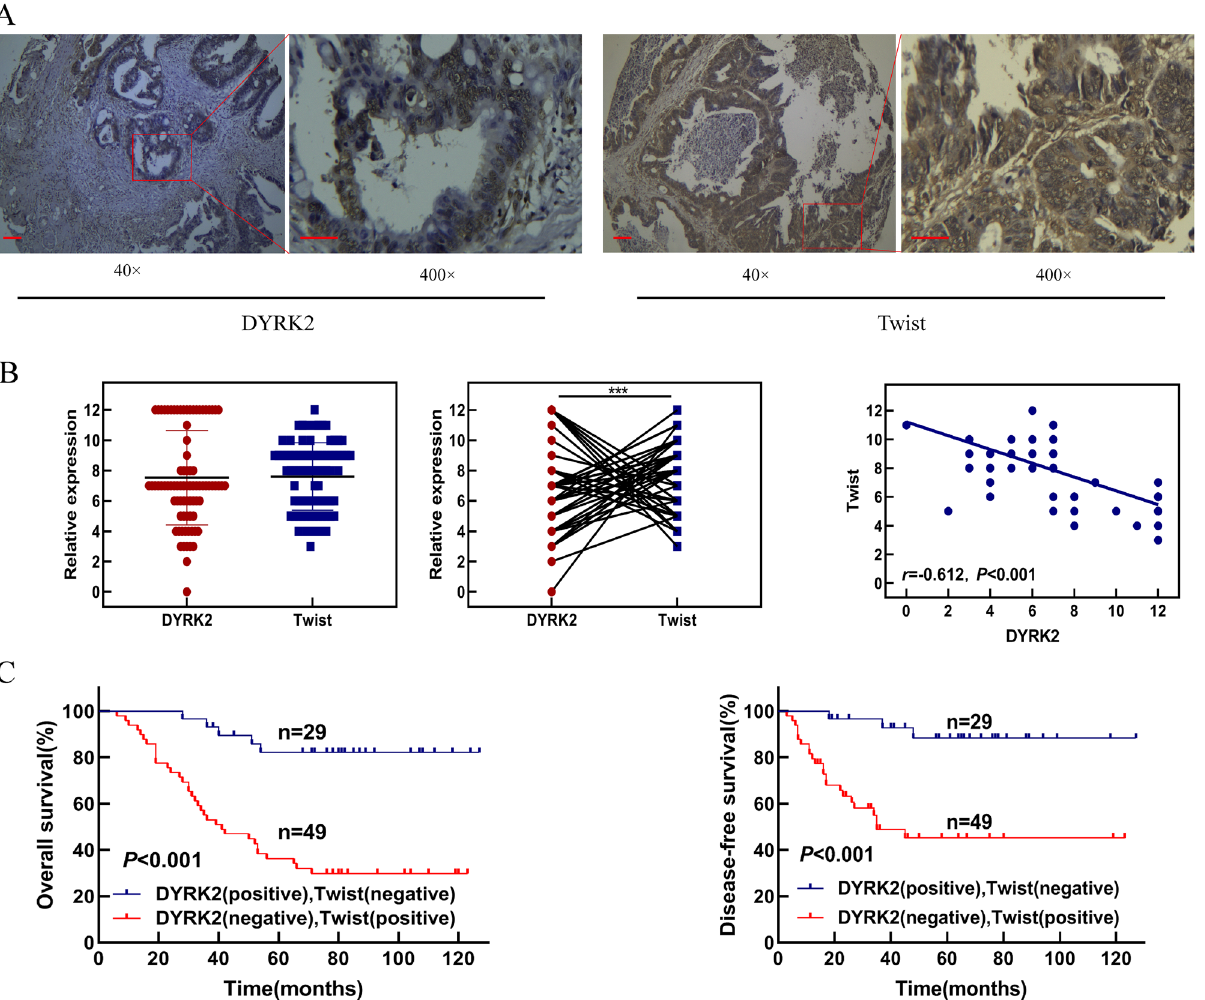
Figure 8. Combination of DYRK2 and Twist levels is useful for predicting clinical prognosis of CRC patients. ( A ) Representative images of IHC staining for DYRK2 and Twist. Note: Scale bar = 100 μm (× 40) or 20 μm (× 400). ( B ) Distribution and correlation analysis of DYRK2 and Twist in CRC samples (r = − 0.612, p < 0.001). ( C ) Prognostic values of DYRK2 combined with